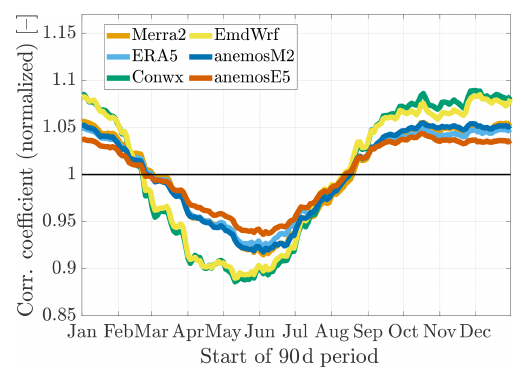
Figure 5. Normalized linear correlation coefficient between mea- surement and reanalysis data (periods of 90d, arithmetically aver- aged over all sites). In the context of normalization the curves were shifted to a mean of 1 to better identify the (relative) temporal vari- ations during the year.